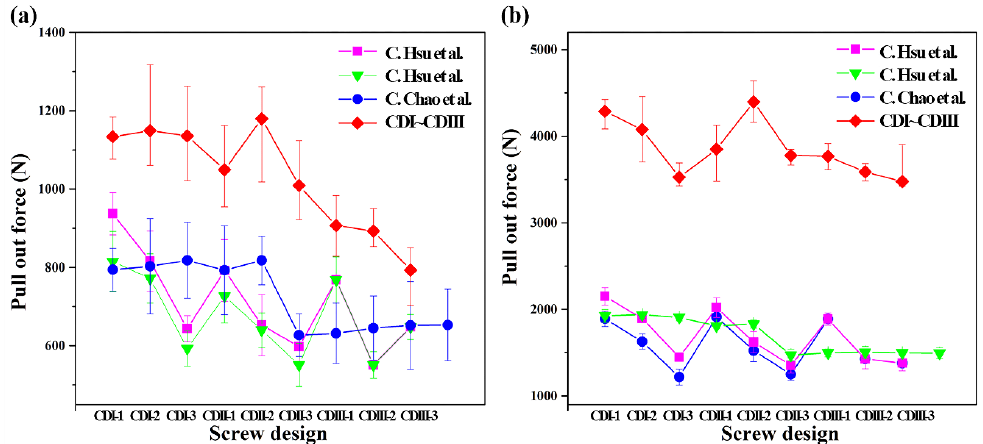
Figure 8. Comparison of pullout force with previous studies with respect to the variables of density and pedicle screw design.